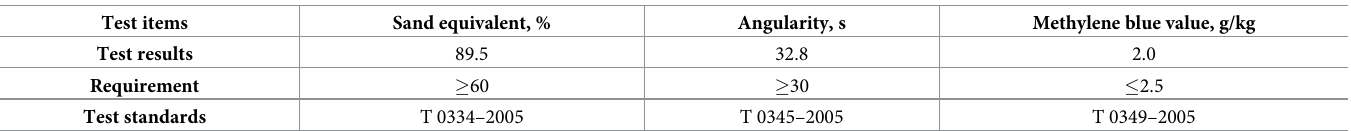
Table 3. Technical properties of fine aggregate.